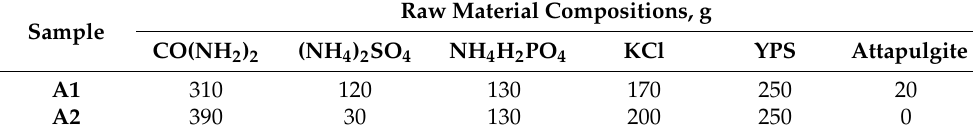
Table 4. Rice fertilizer design and